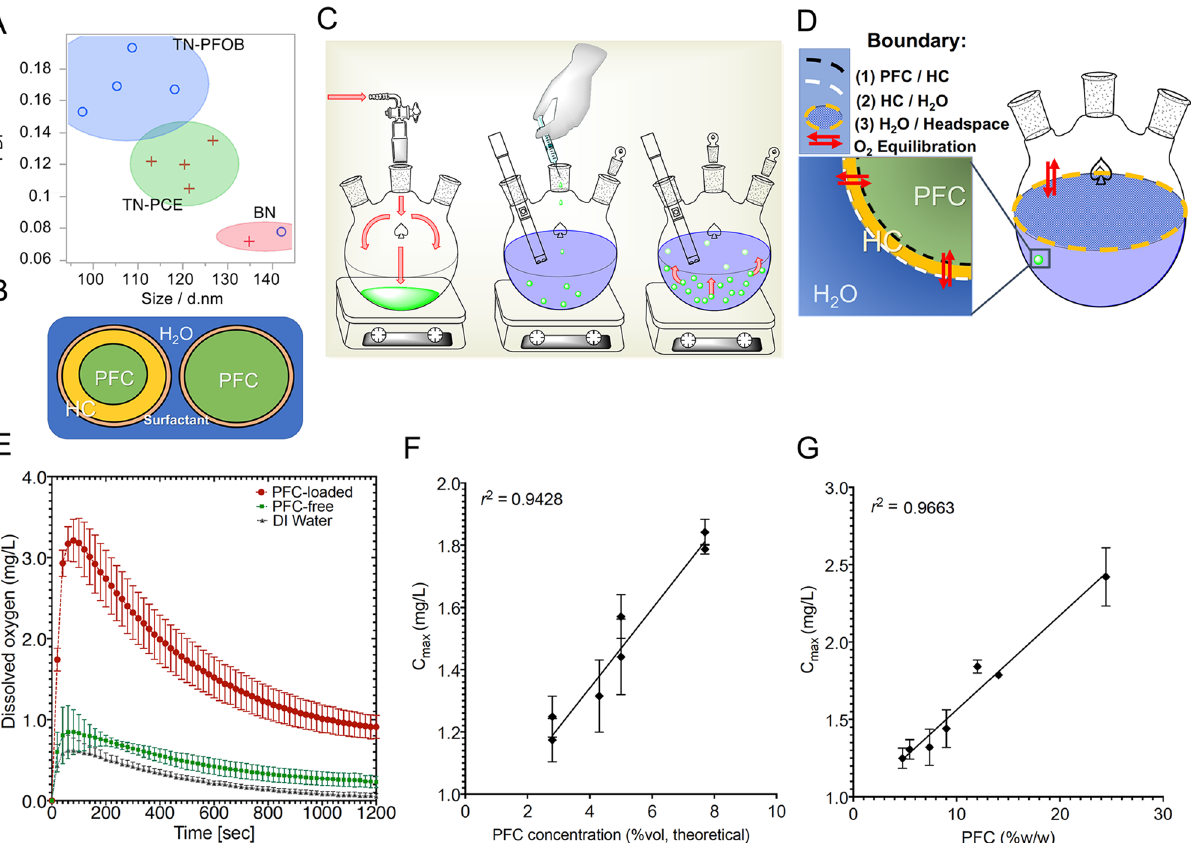
Figure 1. Summary of PFC nanoemulsions (PFC-NEs) for oxygen delivery. ( A ) Scatterplot of nanoemulsion z-average size and polydispersity index (PDI) of biphasic and triphasic nanoemulsions (BNs and TNs, respectively) consisting of perfluorooctyl bromide (PFOB) and perfluoro-15-crown-5-ether (PCE) (JMP Pro). ( B ) Illustration of the configurations of triphasic and biphasic nanoemulsions (TN and BN, respectively). (Microsoft PowerPoint) ( C ) Step-by-step in vitro oxygen loading and release experiments. The oxygen carrier sample is loaded by bubbling oxygen and then passing several passes of oxygen over the headspace. Meanwhile, release medium is deoxygenated by bubbling N 2 and then passing several passes of N 2 over the headspace. Oxygenated sample is removed by needle and syringe and injected into sealed release medium. Dissolved oxygen levels are monitored in the release medium (ChemDraw). ( D ) Schematic showing simplified sequence of interfaces that oxygen equilibrates across in the in vitro oxygen release setup. After loading the PFC-NE with O 2 , the majority of the dissolved oxygen resides in the PFC phase. There is no O 2 in the release medium or the headspace of the round bottom flask. A concentration gradient drives the oxygen from the PFC core first into the hydrocarbon shell in the case of TN, then into the release medium, and finally into the headspace of the vessel. (ChemDraw) ( E ) Representative oxygen release data shows that PFC presence is essential for high levels of oxygen loading. (GraphPad Prism) ( F , G ) Dissolved O 2 maximum concentration (C max ) is linearly proportional to both theoretical PFC concentration, in percent volume, and PFC concentration quantified by 19 F NMR spectroscopy, in percent weight PFC per weight of NMR sample (GraphPad